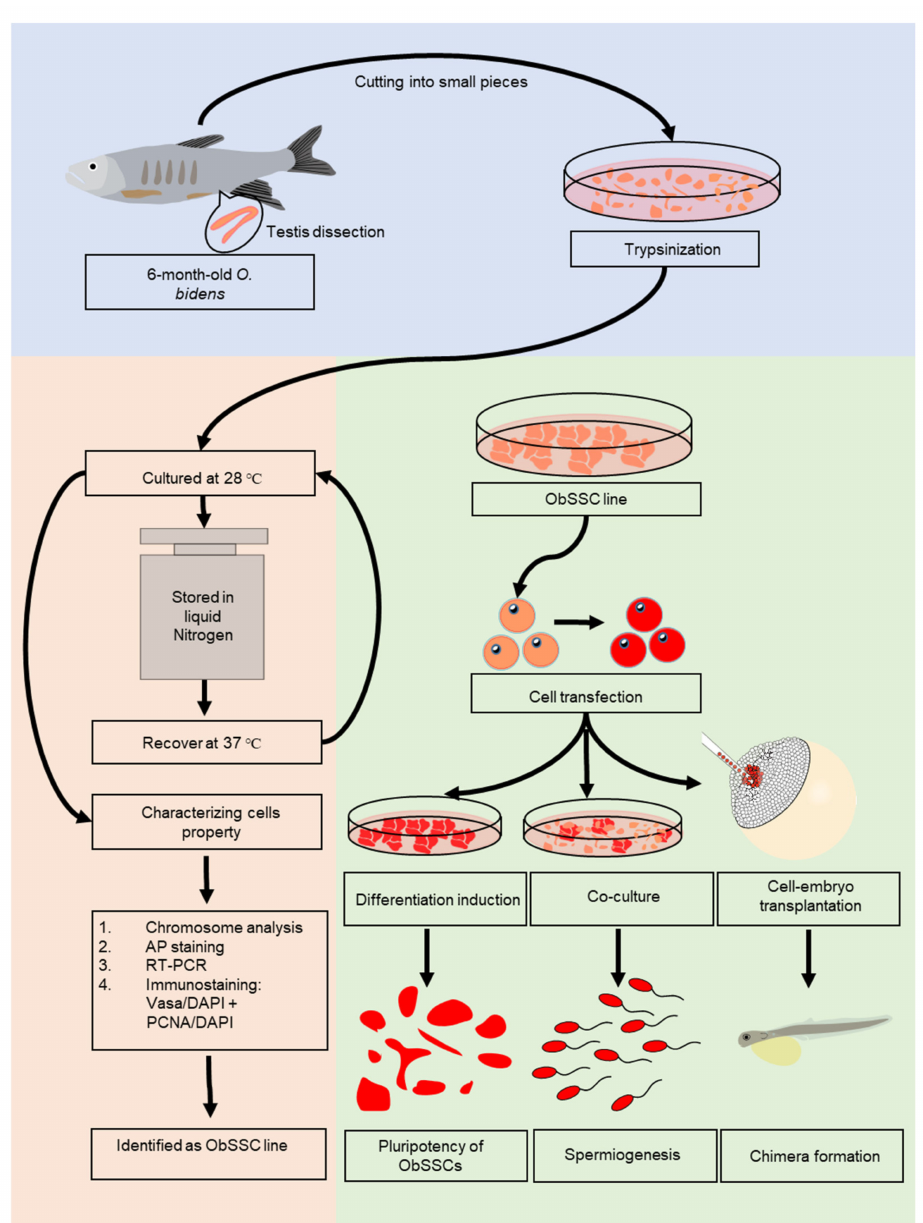
Figure 1. Flowchart of experiments. In total, seven 6-month-old male adult fish with a length of about 10 cm were used. Live fish were placed on ice, and there was no response to mechanical stimulation. Testicular tissues were dissected and washed two times with phosphate-buffered saline (PBS) containing 1% penicillin/streptomycin. All testes were minced and dissociated by trypsin and collagenase. A stable ObSSC line was obtained by appropriate culturing and then cryopreserved. We verified that these cells were SSCs by chromosomal analysis, RT-PCR and immunofluorescence. ObSSCs were identified in vitro and in vivo with pluripotent stem cell properties.